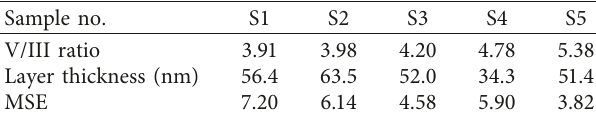
Table 1: Thicknesses and MSE of InSb thin film samples from SE. Sample